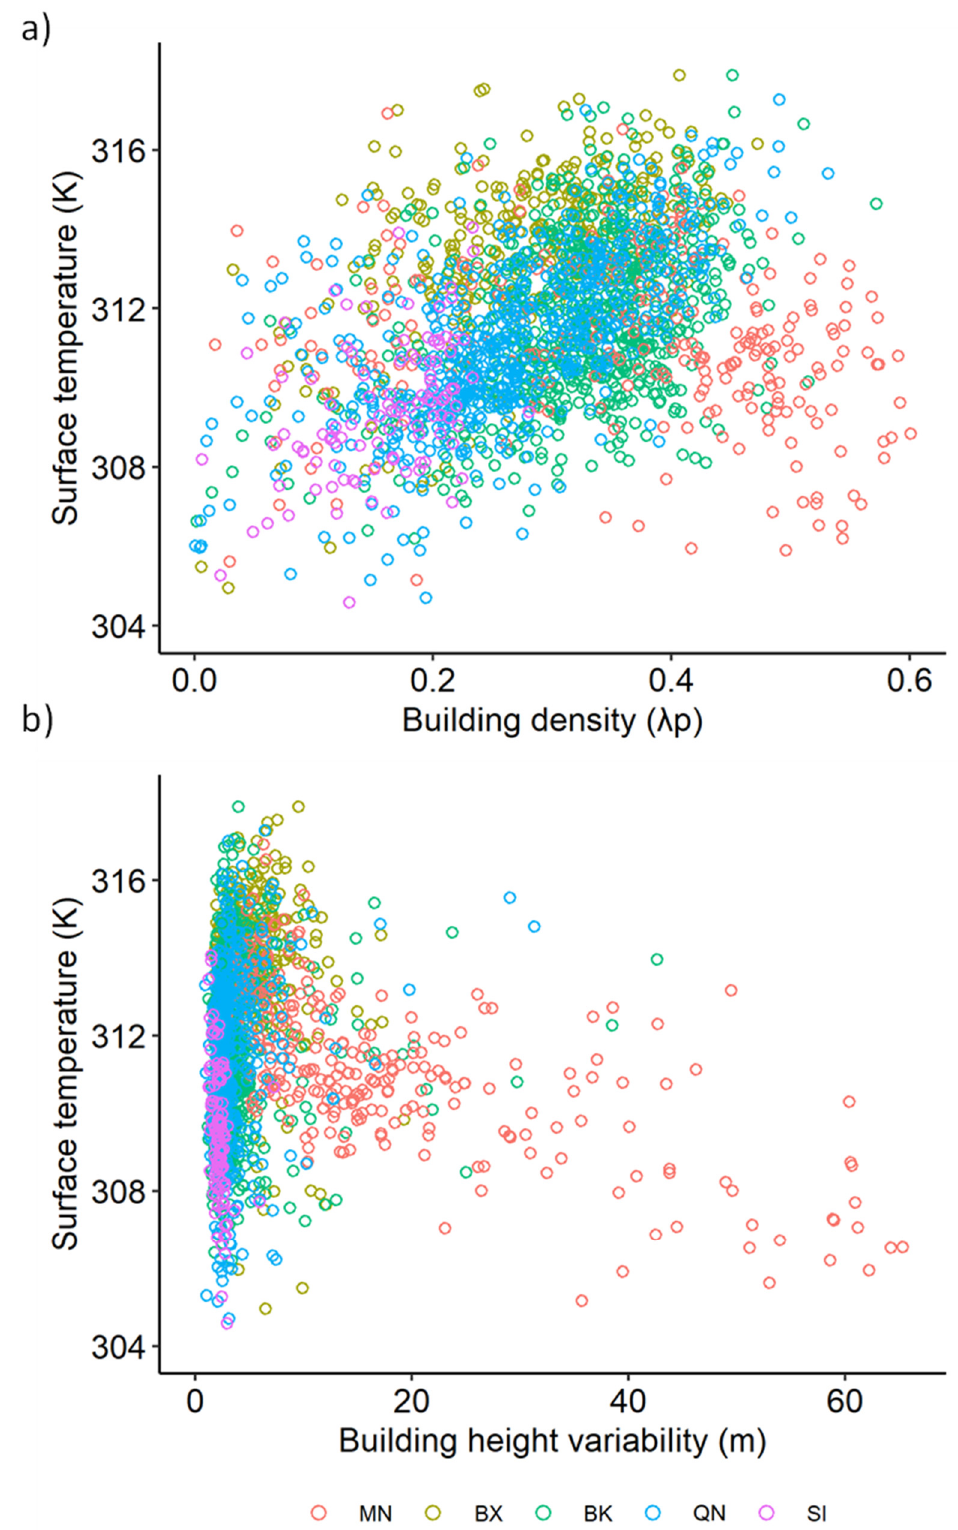
Figure 9. The figure shows the relationships between: ( a ) Surface temperature (mean) and building density (ratio of the total building footprint to the land area), and ( b ) surface temperature (mean) and building height variability (m) in different census tracts of New York City. Different colors signify boroughs of New York City: BK—Brooklyn, BX—Bronx, MN—Manhattan, QN—Queens, and SI—Staten Island.